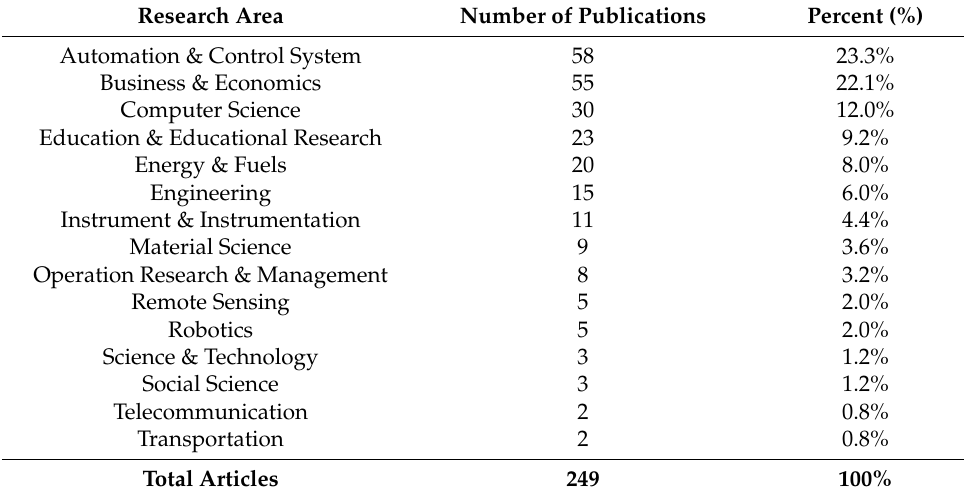
Table 1. Research Table 1. Research area.